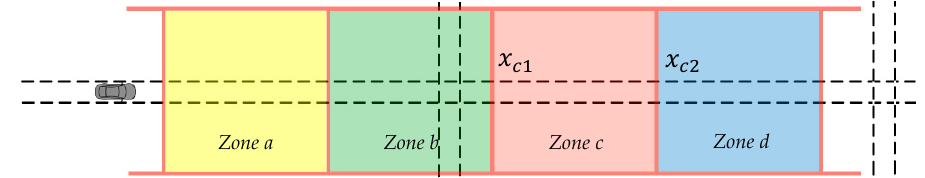
Figure 6. Links of the arterials are segmented by zones. The probability of zones is determined for all the zones a vehicle has ahead.